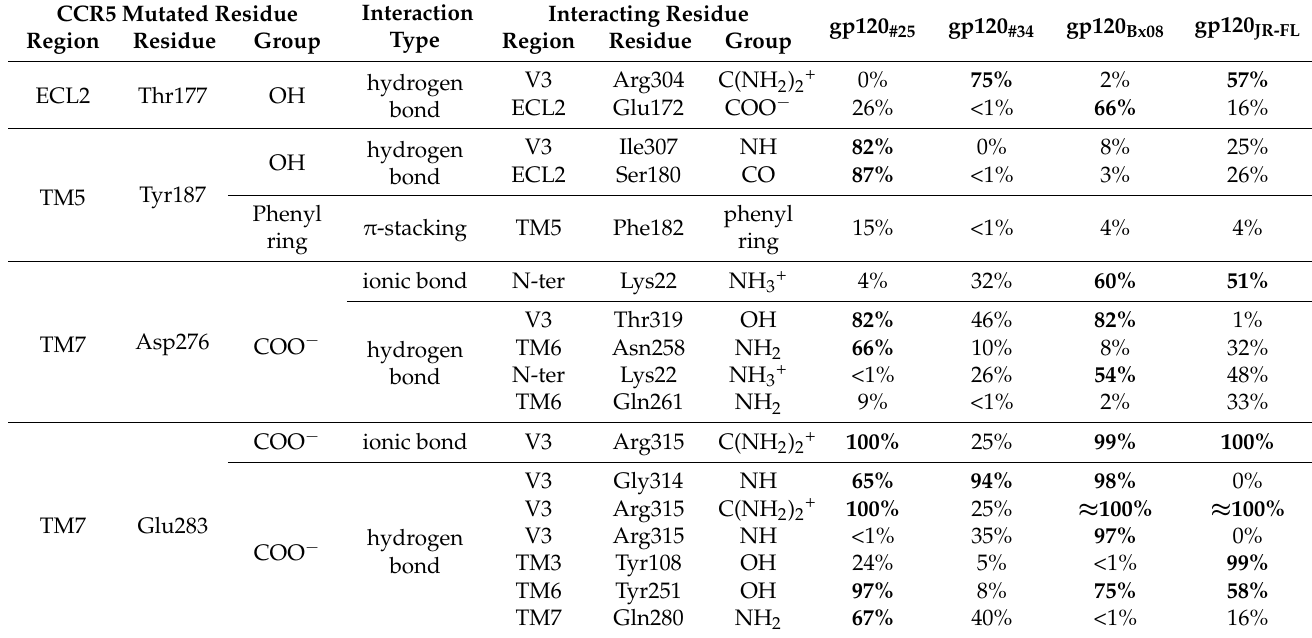
Table 1. Frequency in the simulated structures of the hydrogen bonds, ionic bonds and π -stacking interactions involving the four CCR5 mutated residues. Interaction frequency values greater than 50% are in bold. CCR5 Mutated